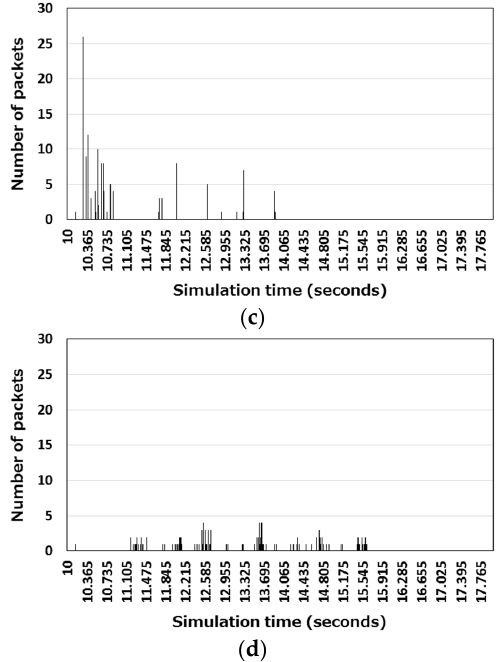
Figure 13. Number of packets that arose in each 10-ms interval during stray node detection processing in the case where the number of nodes was 15. ( a ) AR-Basic; ( b ) AR-Proposal; ( c ) RR-Basic; and ( d ) RR-Proposal.